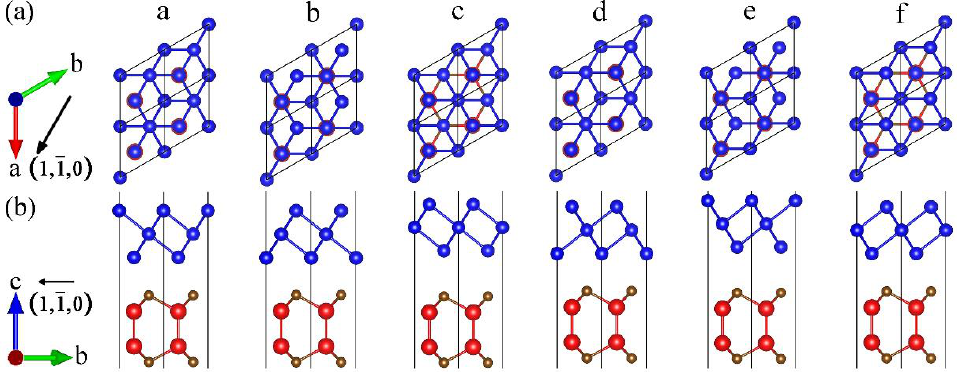
Figure 2. Top ( a ) and side ( b ) views of MX A /X B heterostructures with various configurations. Red, brown, blue balls indicate the M, X A , X B atoms, respectively. Table 1. Most stable configurations, lattice constants a (Å), formation energies E f (meV), binding energies E b (meV/Å 2 ), PBE, and HSE band gaps E PBE g (eV) and E HSE g (eV), and band edge alignment types for MX A /X B vdW